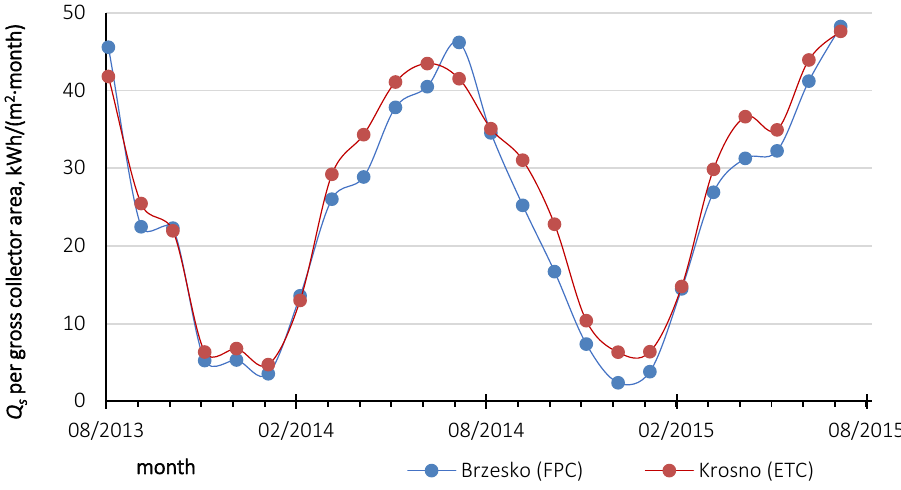
Figure 10. The comparison of solar heat gains per month ( Q s ) coming from the installations in Brzesko and Krosno, calculated in reference to the gross collector area.